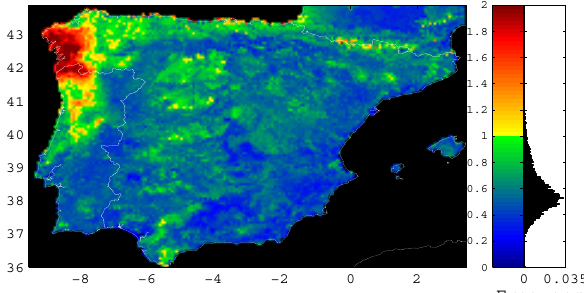
Fig. 3. Spatial patterns of the representativeness of the eddy covari- ance sites for pixels of the Iberian Peninsula. The distance measure (CP d ) of each pixel is computed as the average CP d weighted by the fraction of all the sites used for its parameterization. The right side histogram shows the frequency of the observed CP d for all the pixels in Iberia (Eq. 4).